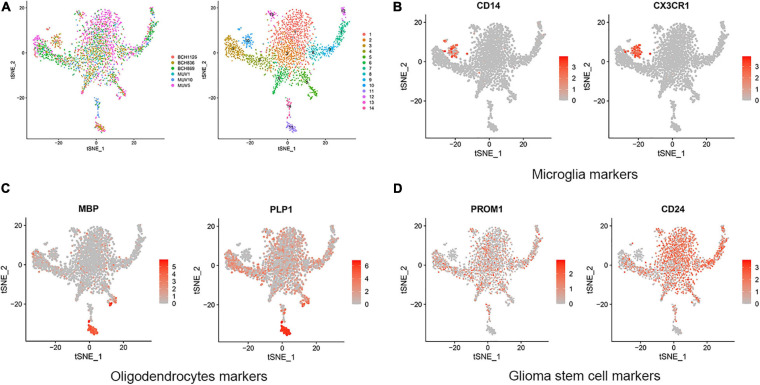
Cell clusters and cell types distribution in six GBM tissue sample. (A) A total of 14 cell clusters was identified and shown with t-SNE maps in six GBM tissue samples. (B–D) T-SNE map showing canonical markers for three cell types: microglia (B), oligodendrocytes (C), and glioma stem cells (D).